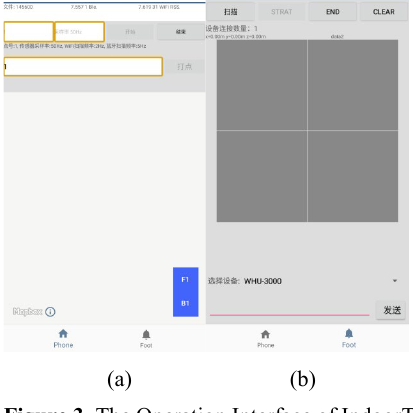
Figure 3 . The Operation Interface of